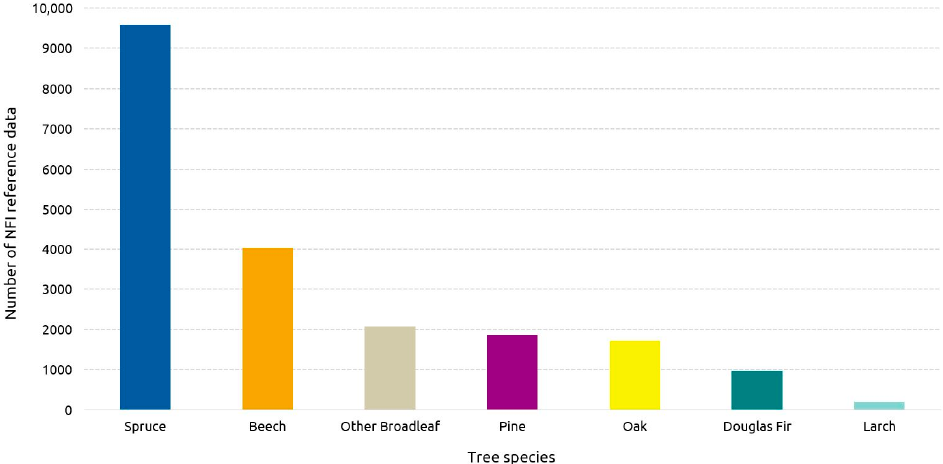
Figure 1. Graph showing the number of spectral–phenological reference data from defined pure stands as derived from the NFI data used in this study. Colors represent the colors of the final dominant tree species map.